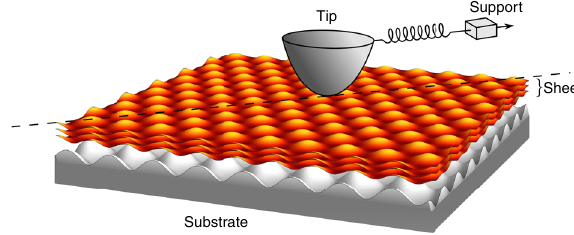
Fig. 1 A sketch of the model system as studied in this work. A tip is dragged via a spring over a sheet comprised of a number of atomically thin layers that lie on a substrate but do not slide on